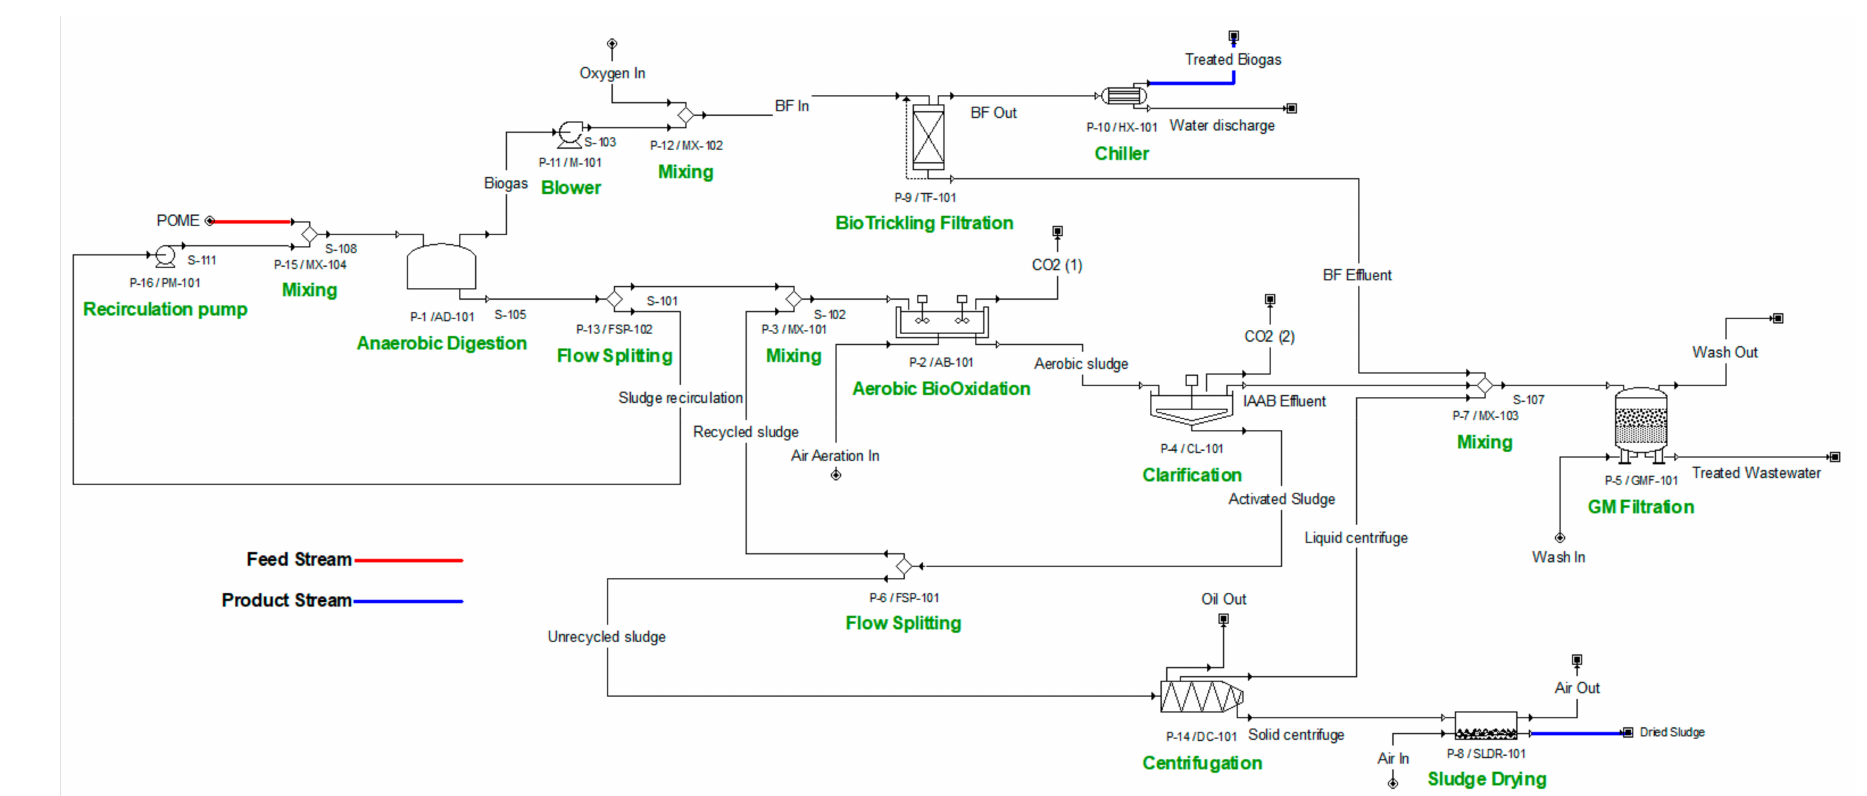
Figure 2. Process flow model for IAAB for the treatment of POME using SuperPro Designer